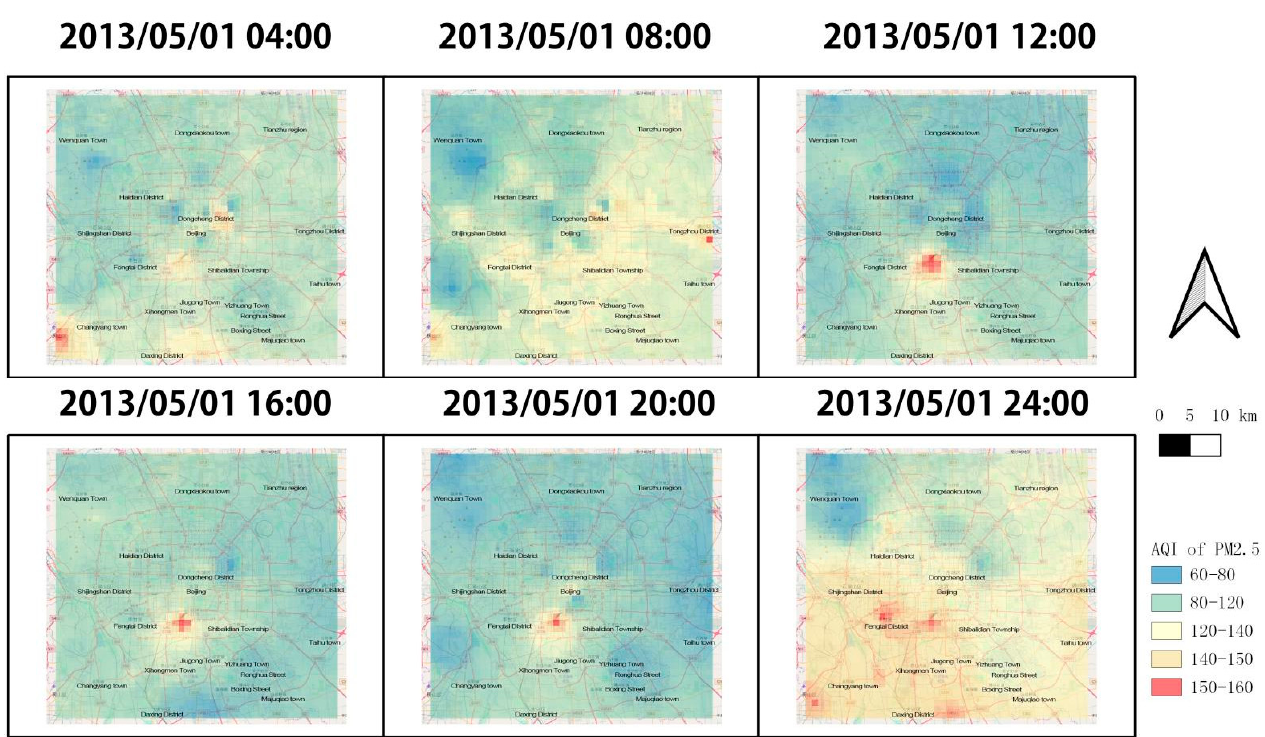
Figure 8. Real-time estimation effect (with partial moment of 1 May 2013 as an example). Black characters are the main place names.